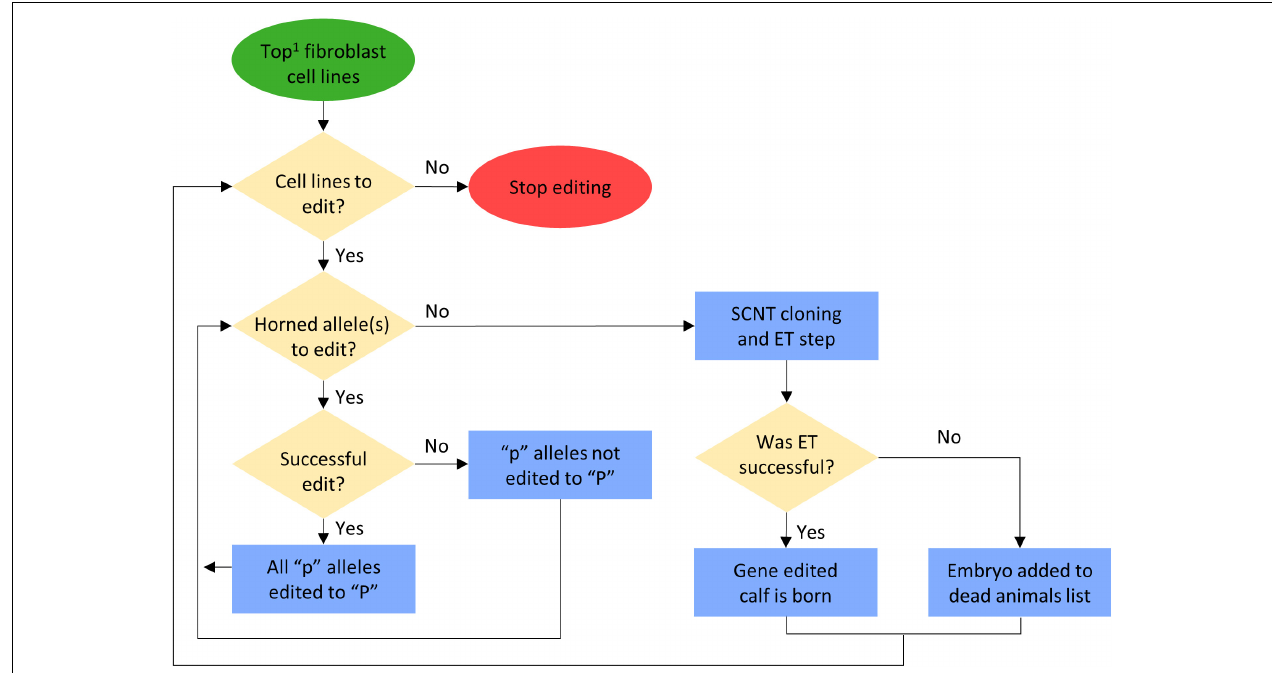
FIGURE 3 | Flowchart for gene editing and embryo transfer (ET) process in the simulation. 1 Potential calves were sorted by their true breeding values (TBV) for the Japan Ox selection index ($JapOx) (highest to